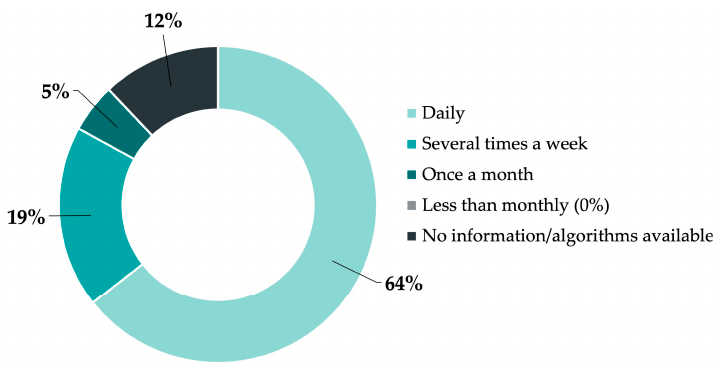
Figure 2. Frequency of use of electronic algorithms in Swiss emergency departments (EDs).